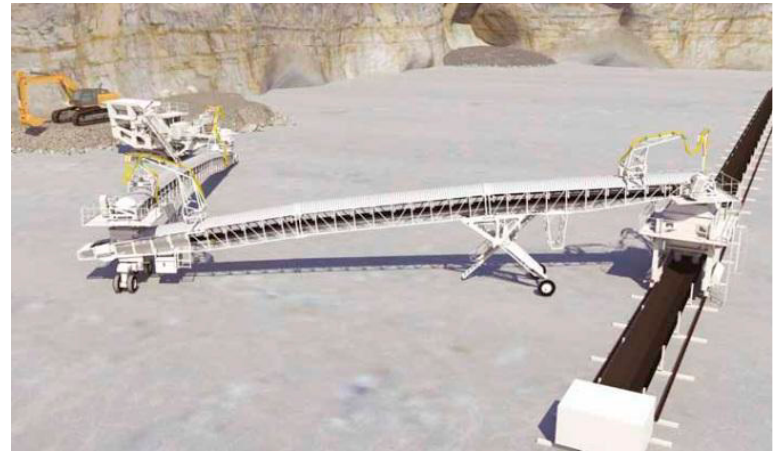
Figure 7. Full-Mobile In-pit Crushing and Conveying systems [38] (Source: McCarthy, 2013).